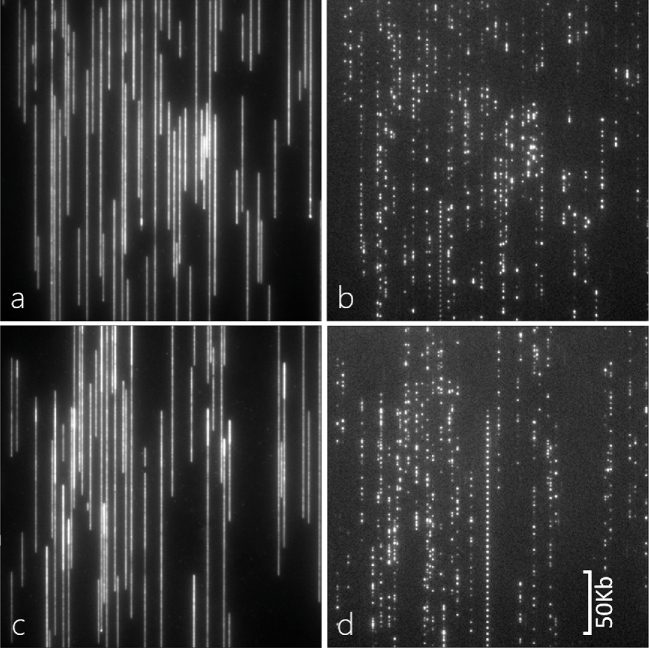
Irys raw images. Labeled high molecular weight DNA was linearized in the chip nano-channel. The restriction sites were digested with Nt.BspQI and labeled with fluorescence dNTP. The DNA backbone (a,c) and labels (b,d) were detected by EM CCD with blue (473 nm) and green (532 nm) lasers, respectively. Raw images in a and b are from M. pentadactyla; and in c and d from M. javanica. The raw molecule data were detected with Irys AutoDetect 2.1.4 from the raw images